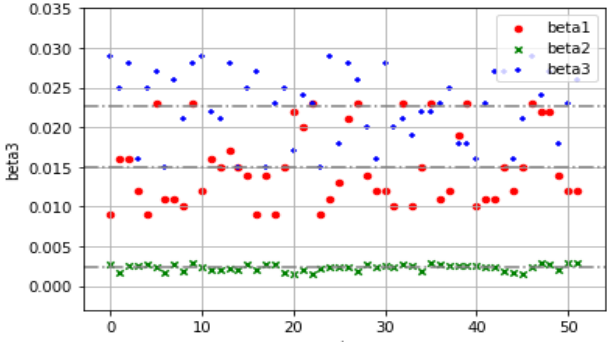
Figure 6. Alpha parameters learning result.